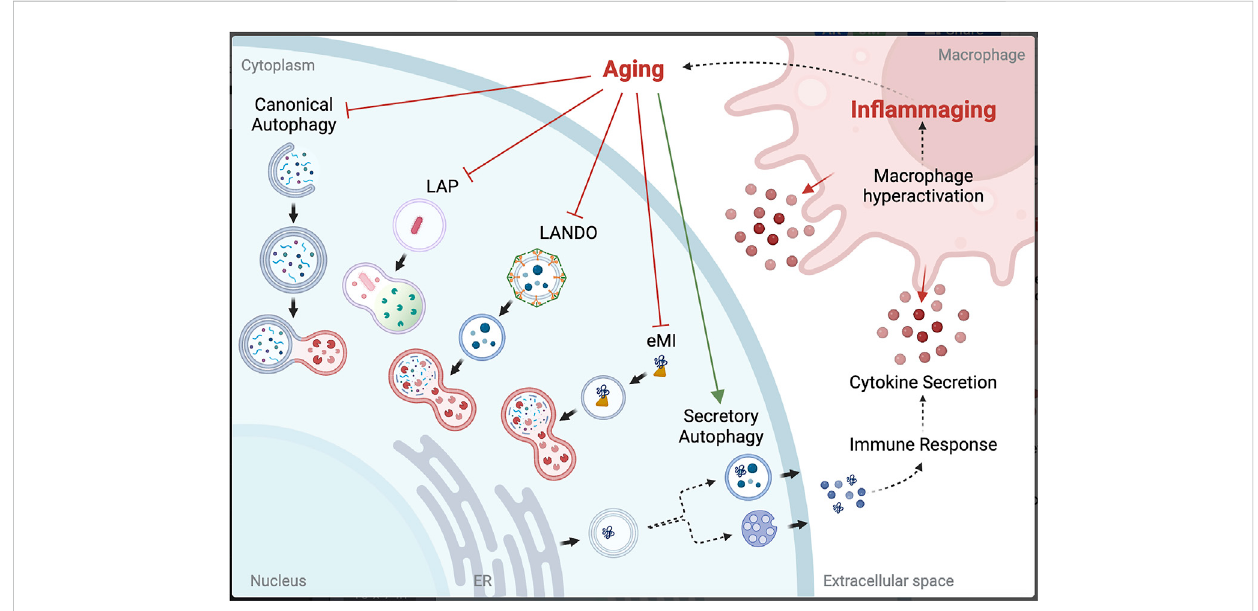
FIGURE 2 Potential link between autophagy dysfunction and in fl ammaging. Created with